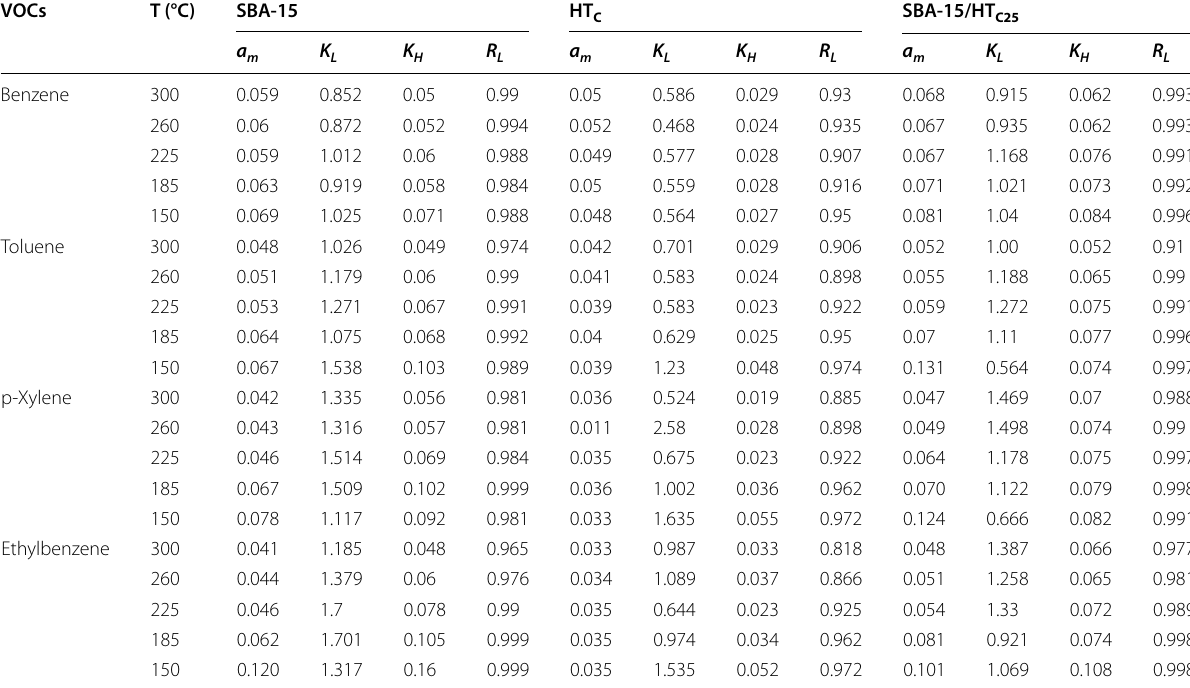
Table 5 Langmuir and Henry model parameters for volatile organic compound (VOC) adsorption in SBA-15, HT and SBA-15/HT